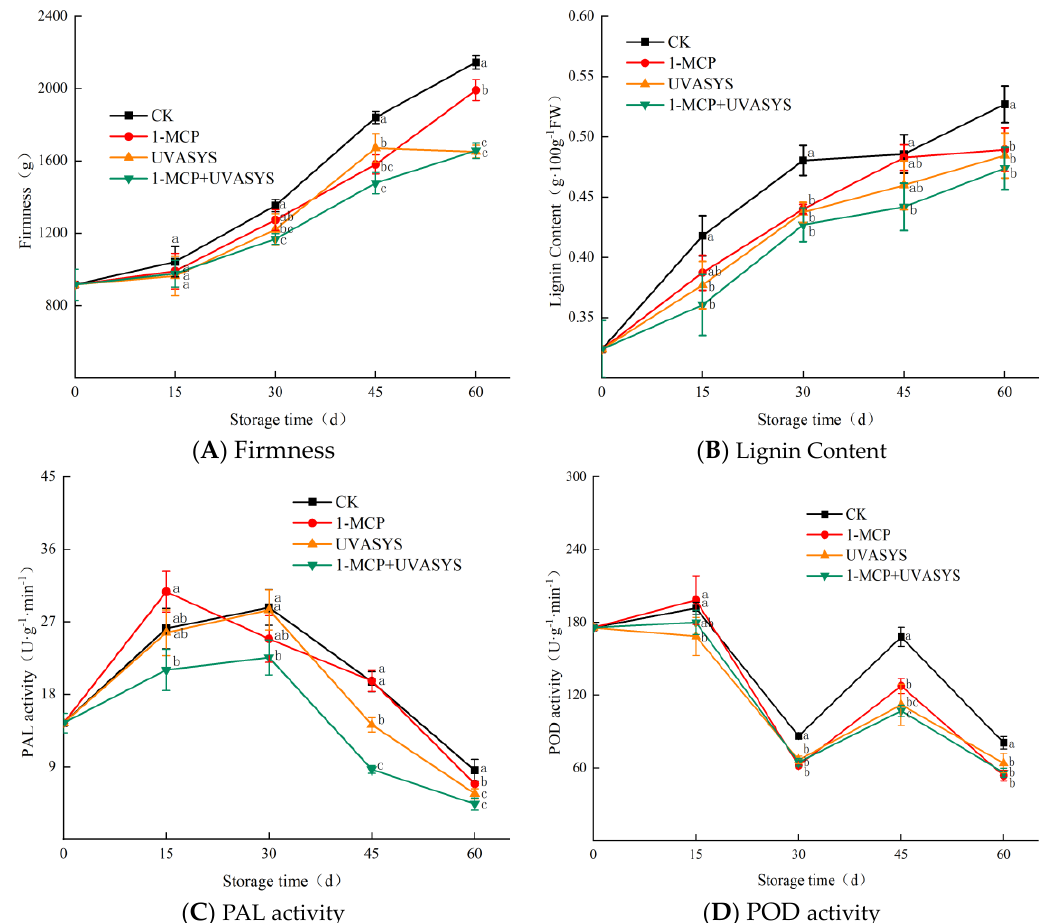
Figure 7. Effects of 1-MCP and UVASYS on Firmness ( A ), Lignin Content ( B ), PAL activity ( C ) and POD activity ( D ) of bamboo shoots during storage. Each data point represents an average ± standard error ( n = 3). Different letters indicate significant differences among treatments for each sampling time at p < 0.05.